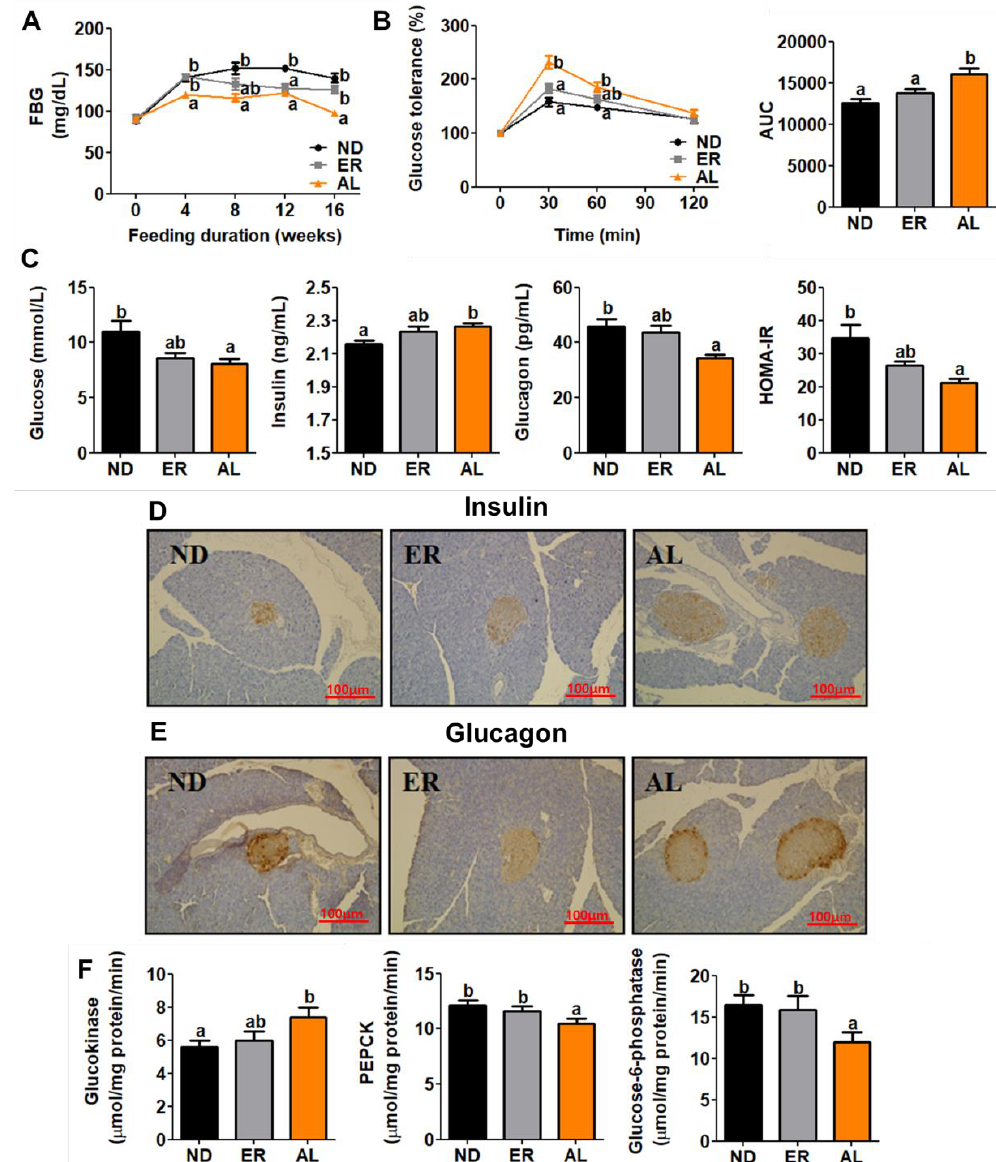
Figure 2. Effect of AL supplementation for 16 weeks on; FBG ( A ), IPGTT ( B ), plasma glucose, insulin